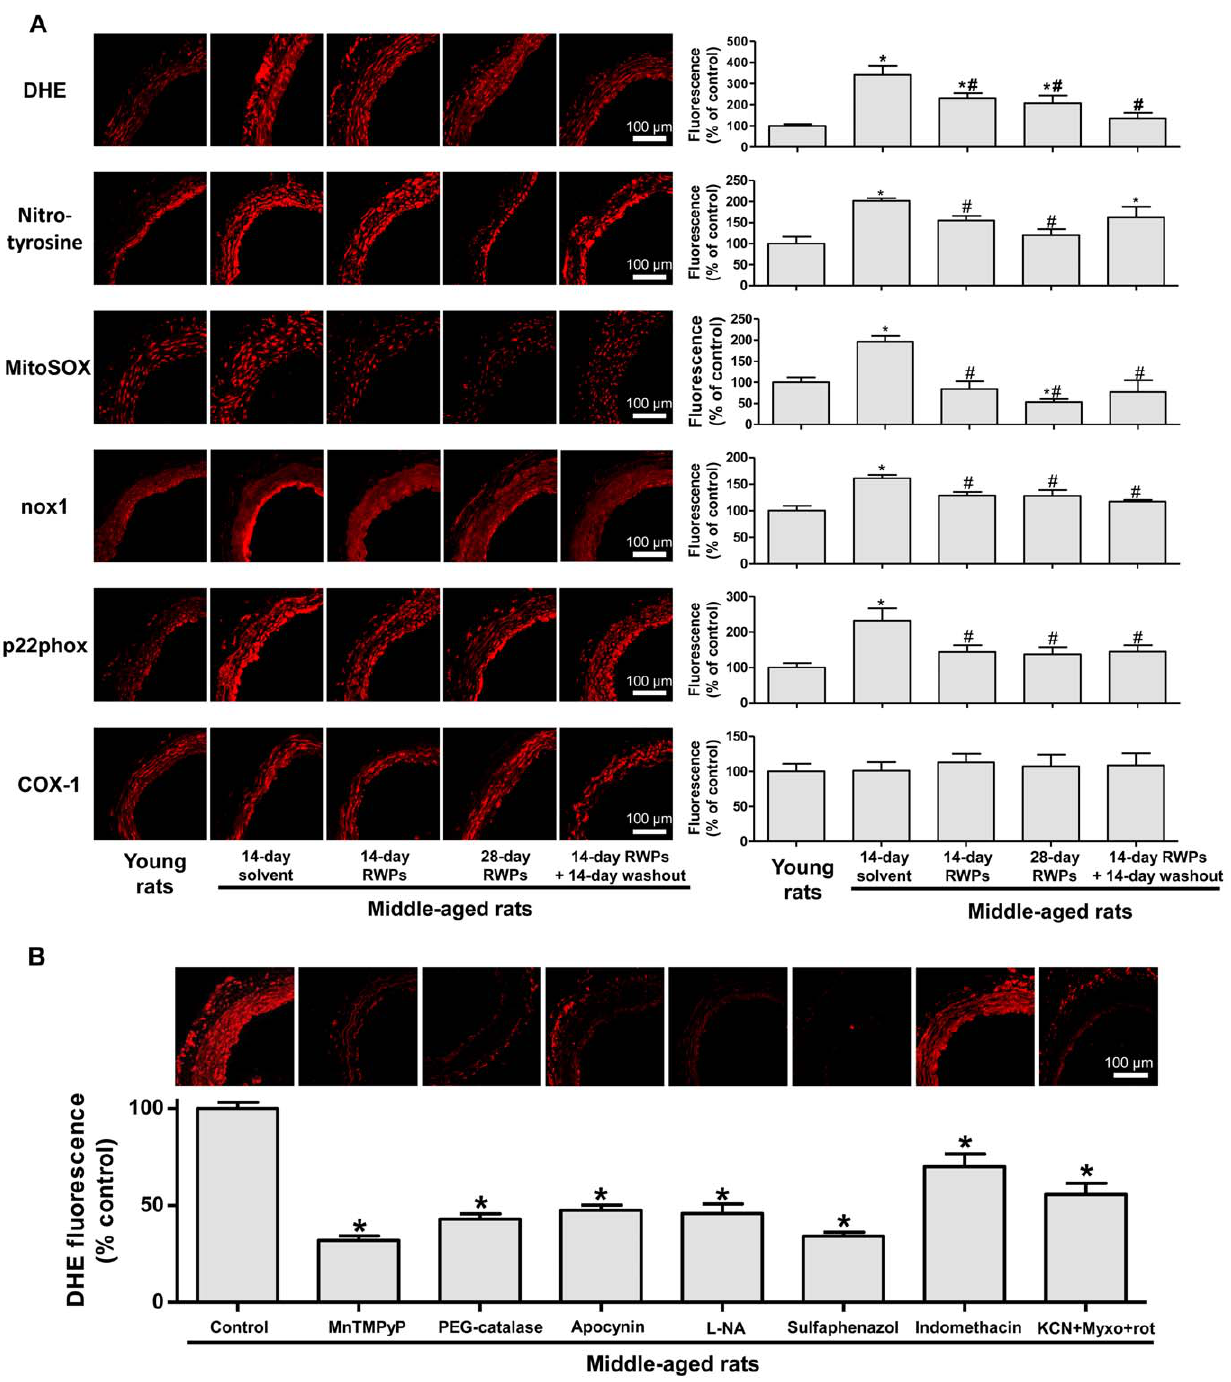
Figure 5. RWPs treatment reduces oxidative stress in the mesenteric artery of middle-aged rats: several sources are involved. Oxidative stress in mesenteric artery sections was determined using the redox-sensitive fluorescent dye dihydroethidine (DHE), nitrotyrosine immunohistochemical staining and the mitochondrial redox-sensitive dye, MitoSOX. In addition, immunohistochemical staining of the NADPH oxidase subunits nox1 and p22phox, and COX-1 is also shown. a) Left panels show representative photographs; right panels corresponding cumulative data. b) Mesenteric artery sections from middle-aged rats were exposed either to MnTMPyP (membrane-permeant superoxide dismutase mimetic), PEG-catalase (membrane-permeant catalase), apocynin (NADPH oxidase inhibitor), L-NA (NO synthase inhibitor), sulfaphenazol (cytochrome P450 inhibitor), indomethacin (cyclooxygenase inhibitor) or inhibitors of the mitochondrial respiration chain (KCN, myxothiazol, and rotenone) for 30 min before DHE staining. Upper panel represents ethidium staining; lower panel corresponding cumulative data. Results are shown as mean 6 SEM of 4 different rats. * P , 0.05 indicates a significant difference versus the young rat control group (a) and the middle-aged rat control group (b), and # P , 0.05 versus the middle-aged rat control group. All micrographs were taken at the same magnification.